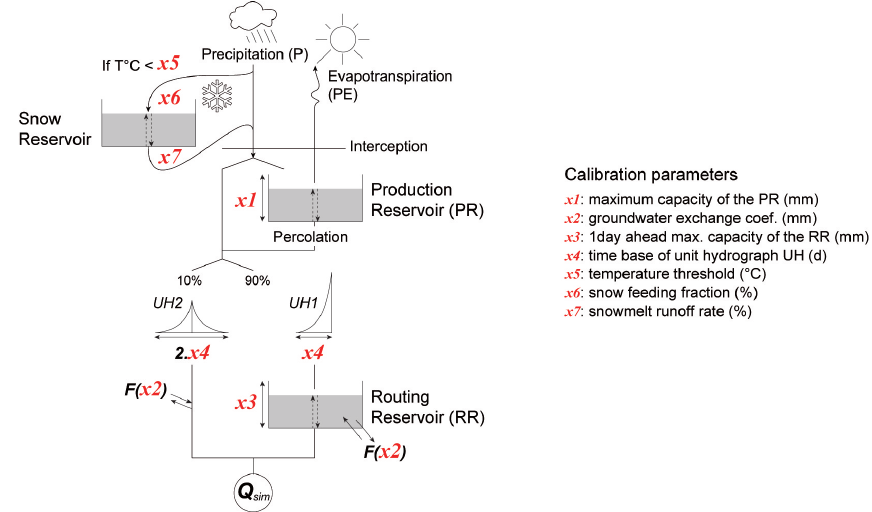
Figure 3. Schematic diagram of hydrological model GR4J. Adapted from Perrin et al. (2003), and Ruelland et al.